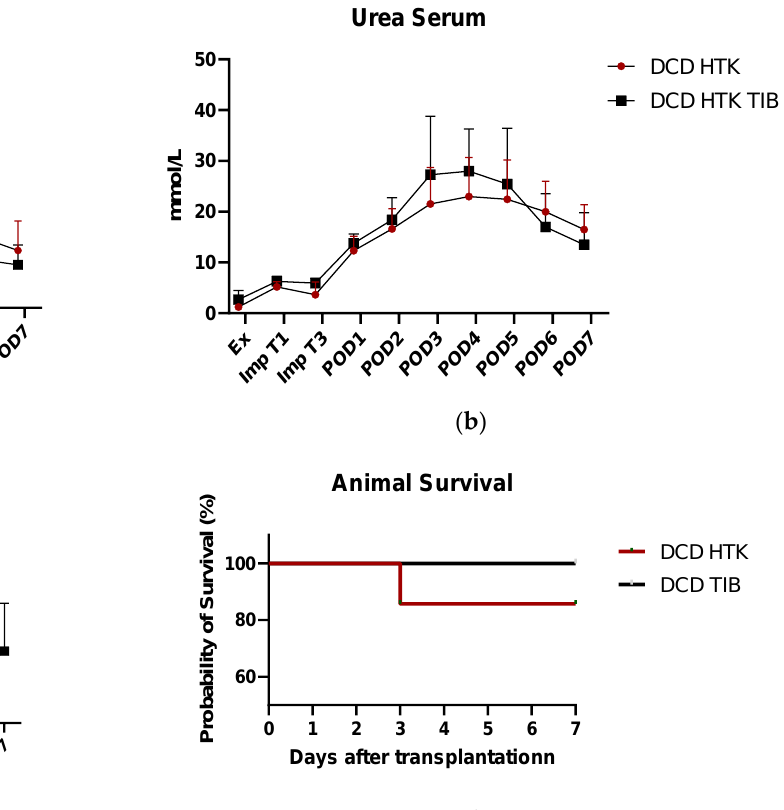
Figure 3. Exemplary results of clinical values and survival for 7 days post operatively = POD. ( a ) Creatinine serum levels ( b ) Urea serum levels ( c ) CRP Serum levels ( d ) Animal survival. * p < 0.05, ** p > 0.01 2- Way ANOVA Sidak’s multiple comparison.